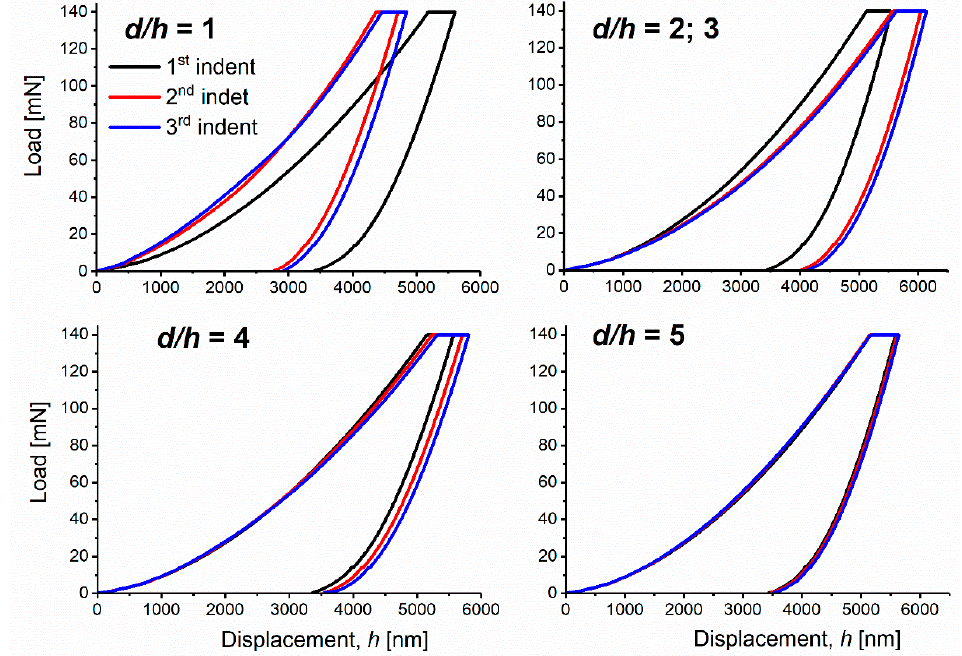
Figure 7. Typical load–displacement curves at low nominal separations. Example is given for h = 5 µm recorded at constant load of 140 mN.